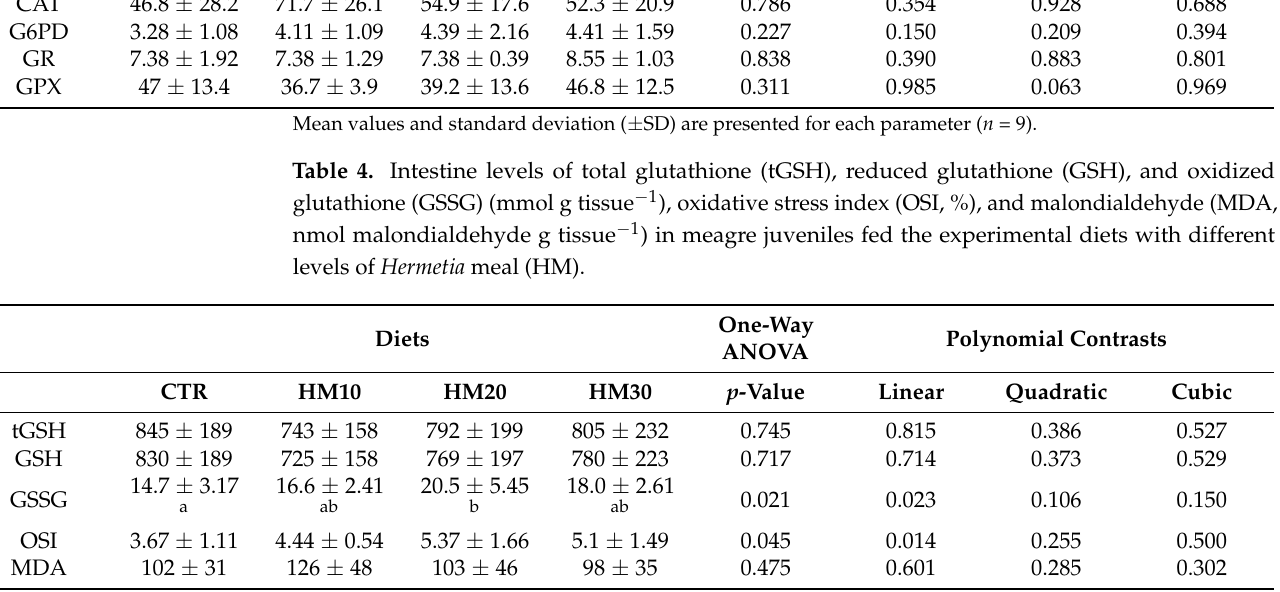
Table 3. Intestine levels of superoxide dismutase (SOD) and catalase (CAT) (U mg protein − 1 ), glucose- 6-phosphate dehydrogenase (G6PD), glutathione reductase (GR), and glutathione peroxidase (GPX) (mU mg protein − 1 ) activities in meagre juveniles fed the experimental diets with different levels of Hermetia meal (HM). One-Way Polynomial Contrasts Diets ANOVA Linear Quadratic Cubic